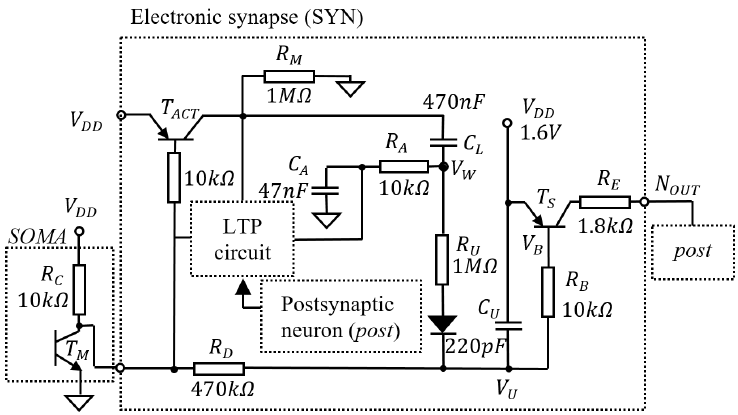
Figure 1. The main elements of the neuronal schematic that are used to model the mechanisms of